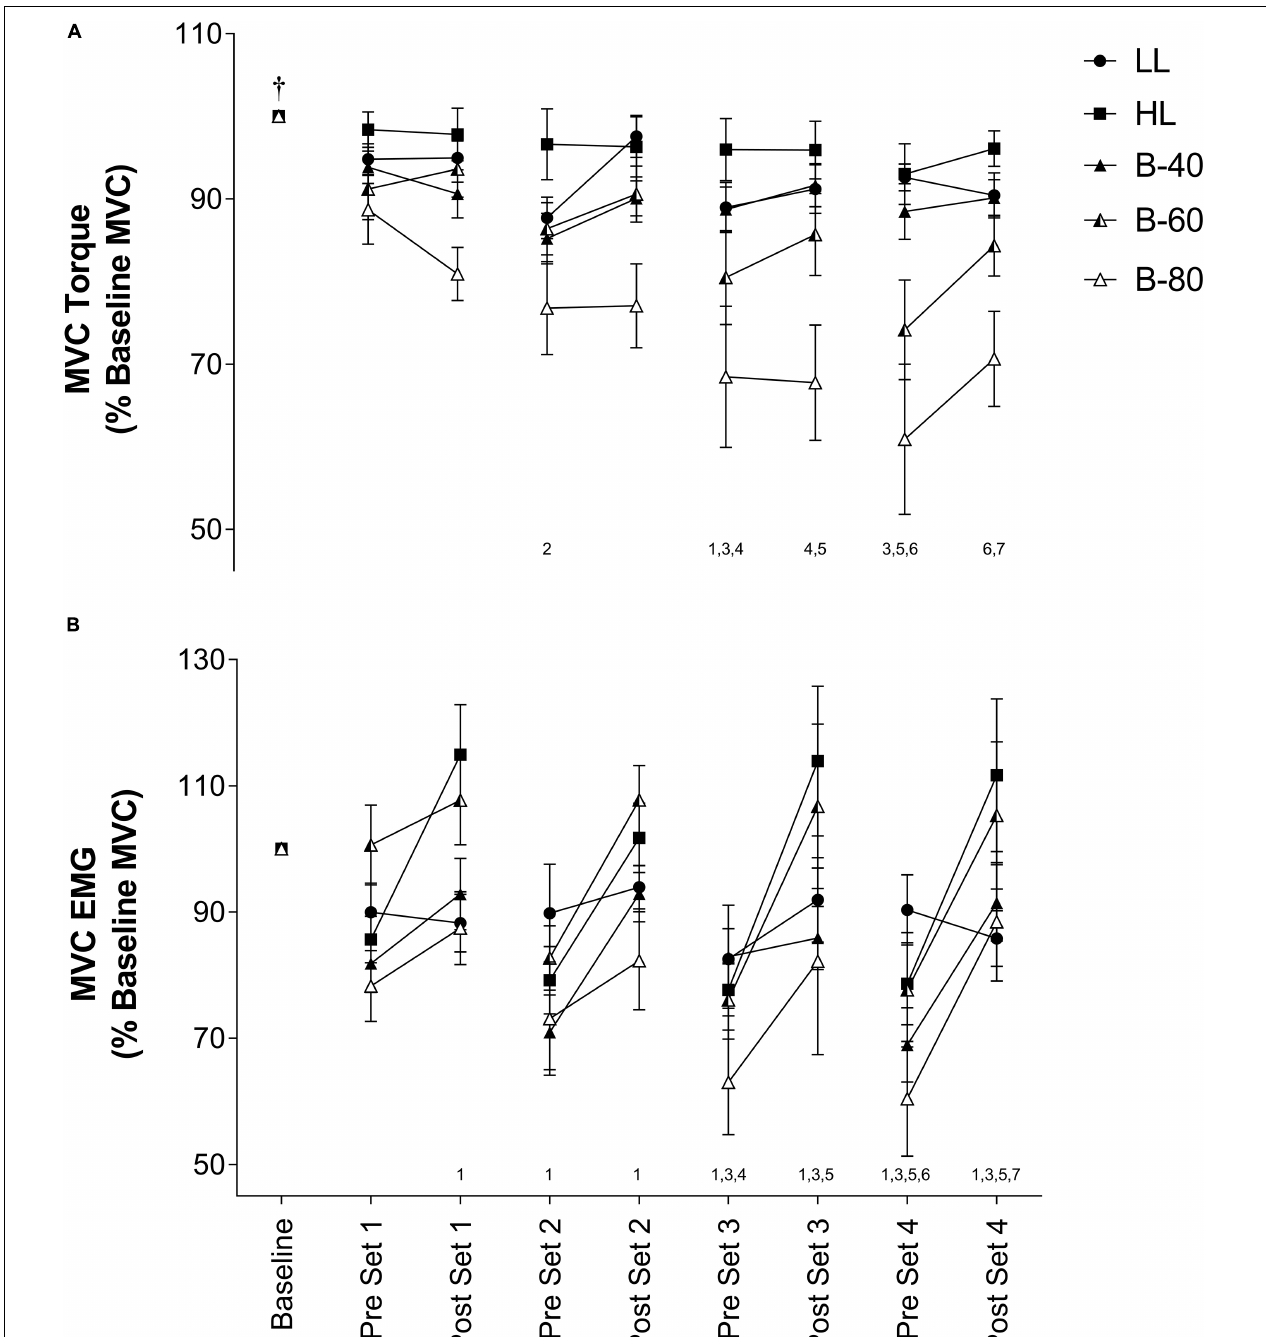
FIGURE 2 | (A) Maximal voluntary contraction (MVC) torque and (B) MVC electromyography (EMG) in the Vastus Lateralis muscle during all five trials [heavy load (HL), light load (LL), 40% limb occlusion pressure (B-40), 60% limb occlusion pressure (B-60), 80% limb occlusion pressure (B-80)]. Values are presented as mean ± SEM. Number values along x -axis represent a significant Time effect from the number of time points indicated prior. † Indicates a significant Time effect from all other time points. Significance set at p < 0.05.